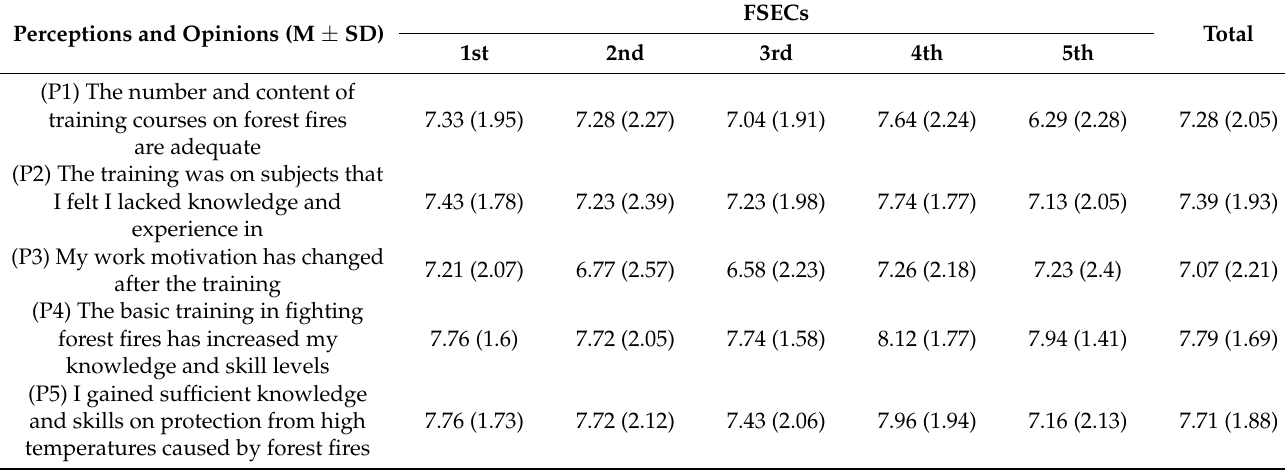
Table 7. Perceptions and opinions of FFFs on in-service